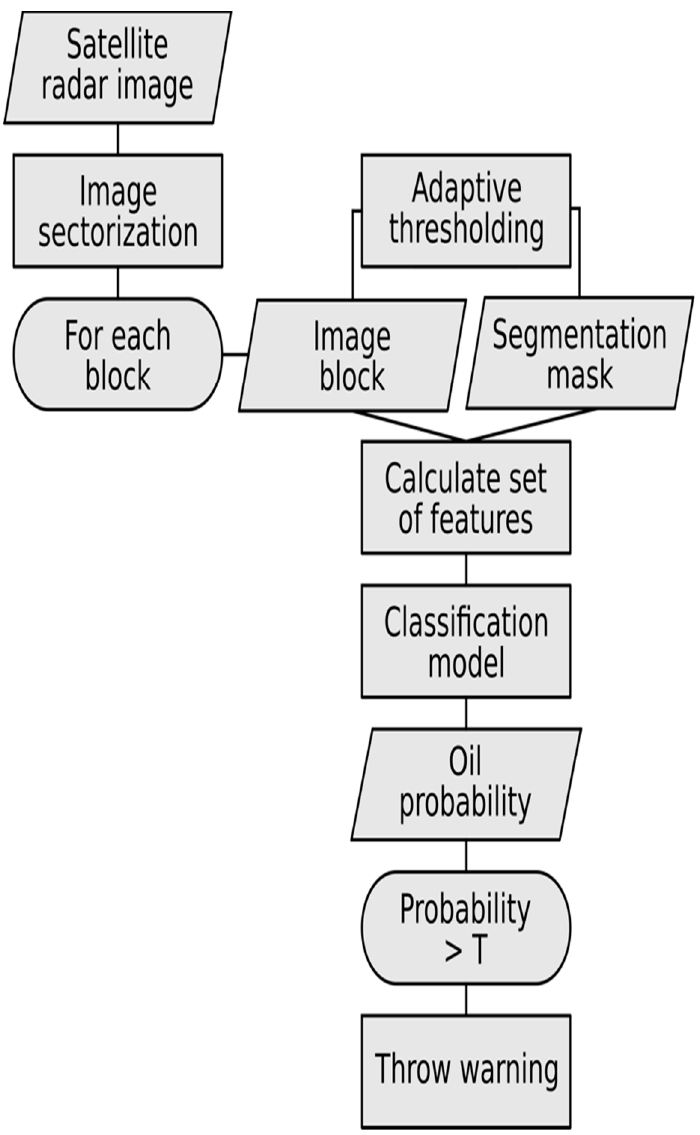
Figure 1. Flux diagram for RIOSS, the proposed automatic oil spill monitoring system.